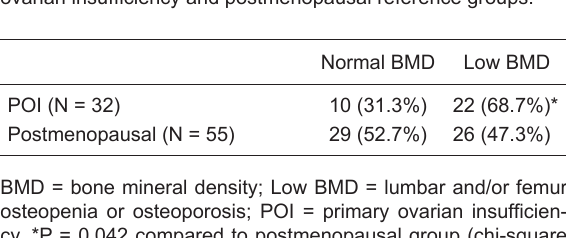
Table 5. Age at menopause, body mass index and hormonal pro- file of women with primary ovarian insufficiency, stratified by bone mineral density.